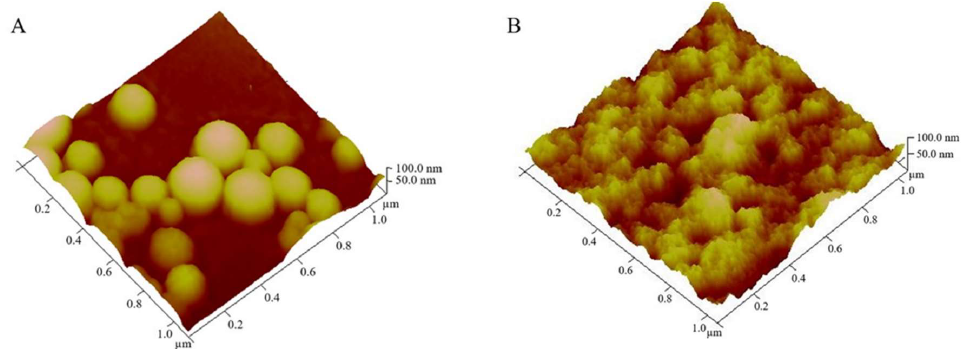
Figure 6. Atomic Force Microscopy (AFM) analysis 3D images of: ( A ) Albumin empty nanoparticles and ( B ) Parvifloron D-loaded nanoparticles.